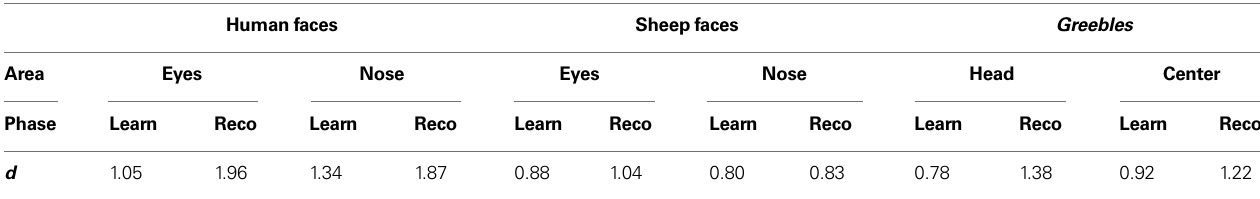
Table 2 | Cohen’s d values for signifi cantly fi xated